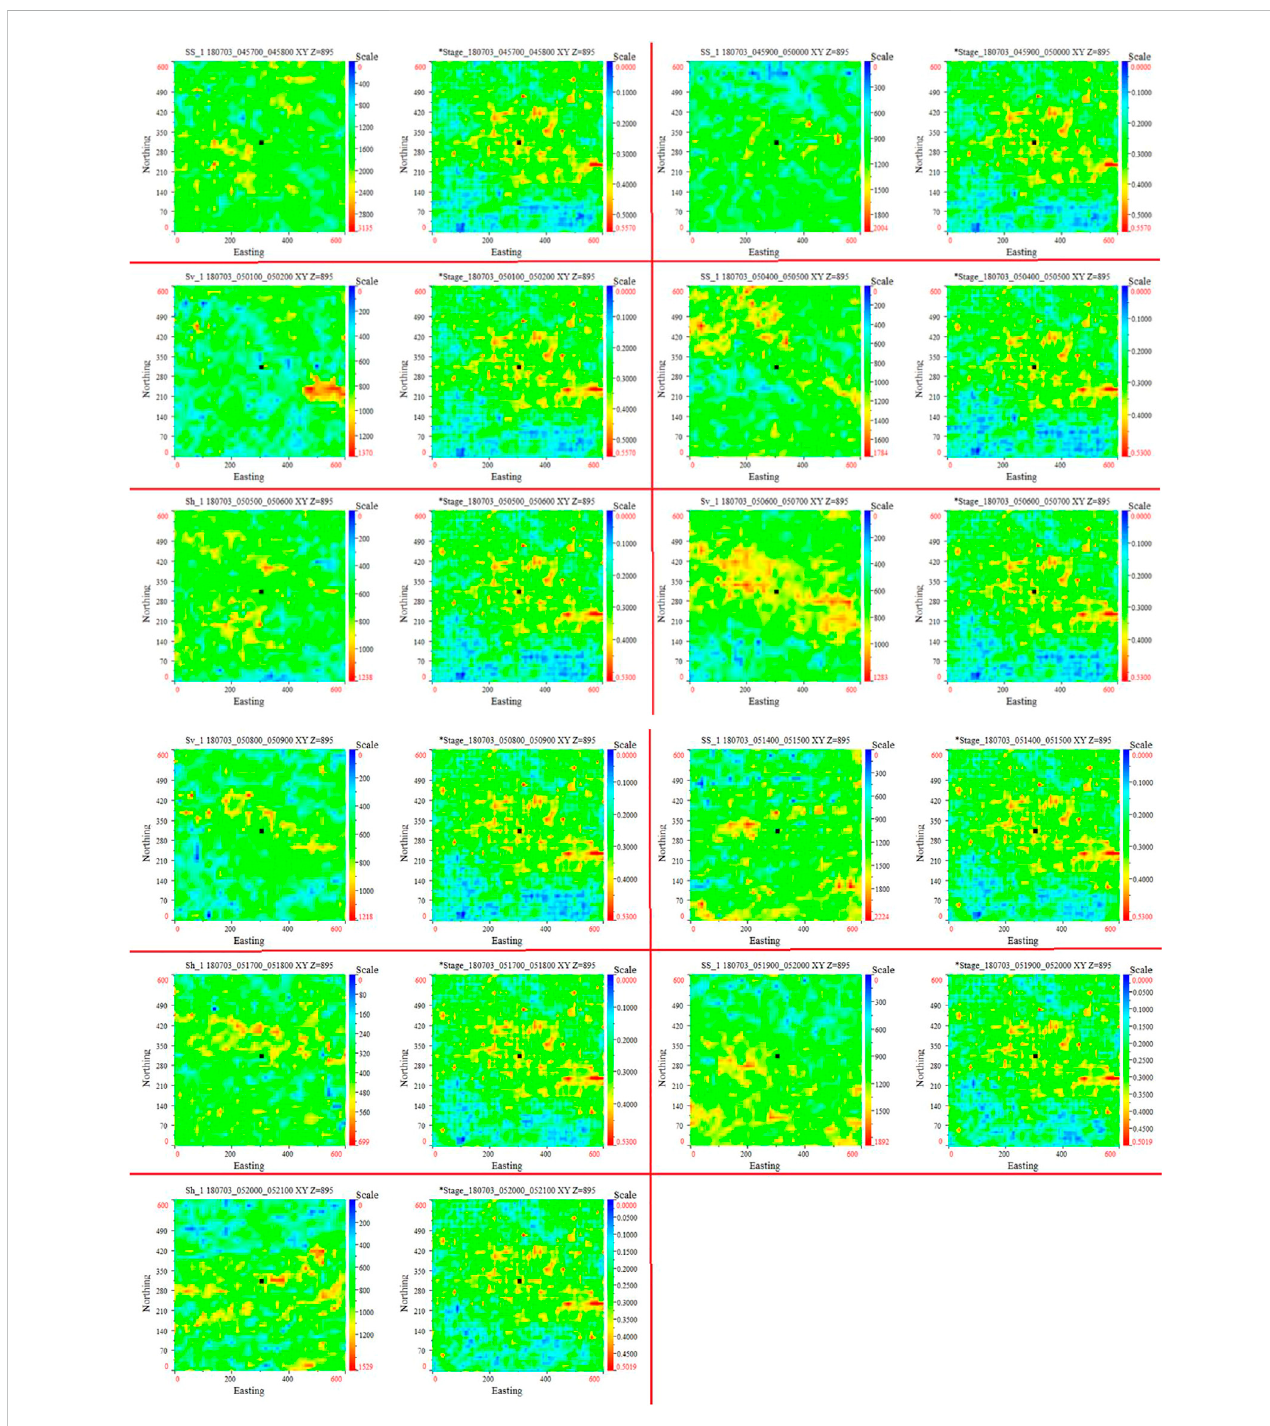
Figure 6. Finally the relevant parameters of fracturing were determined (Liang et al.,